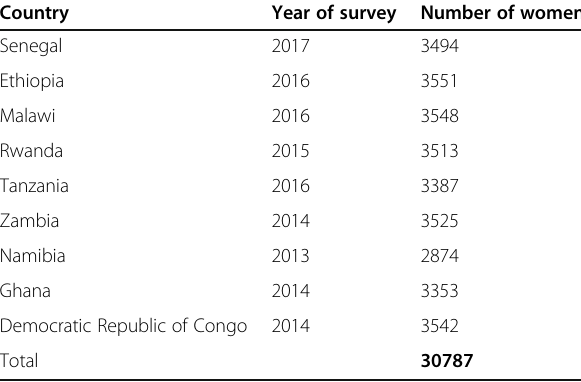
Table 1 Year of survey and number of women in the nine Sub- Saharan Africa using Demographic and Health Surveys 2013